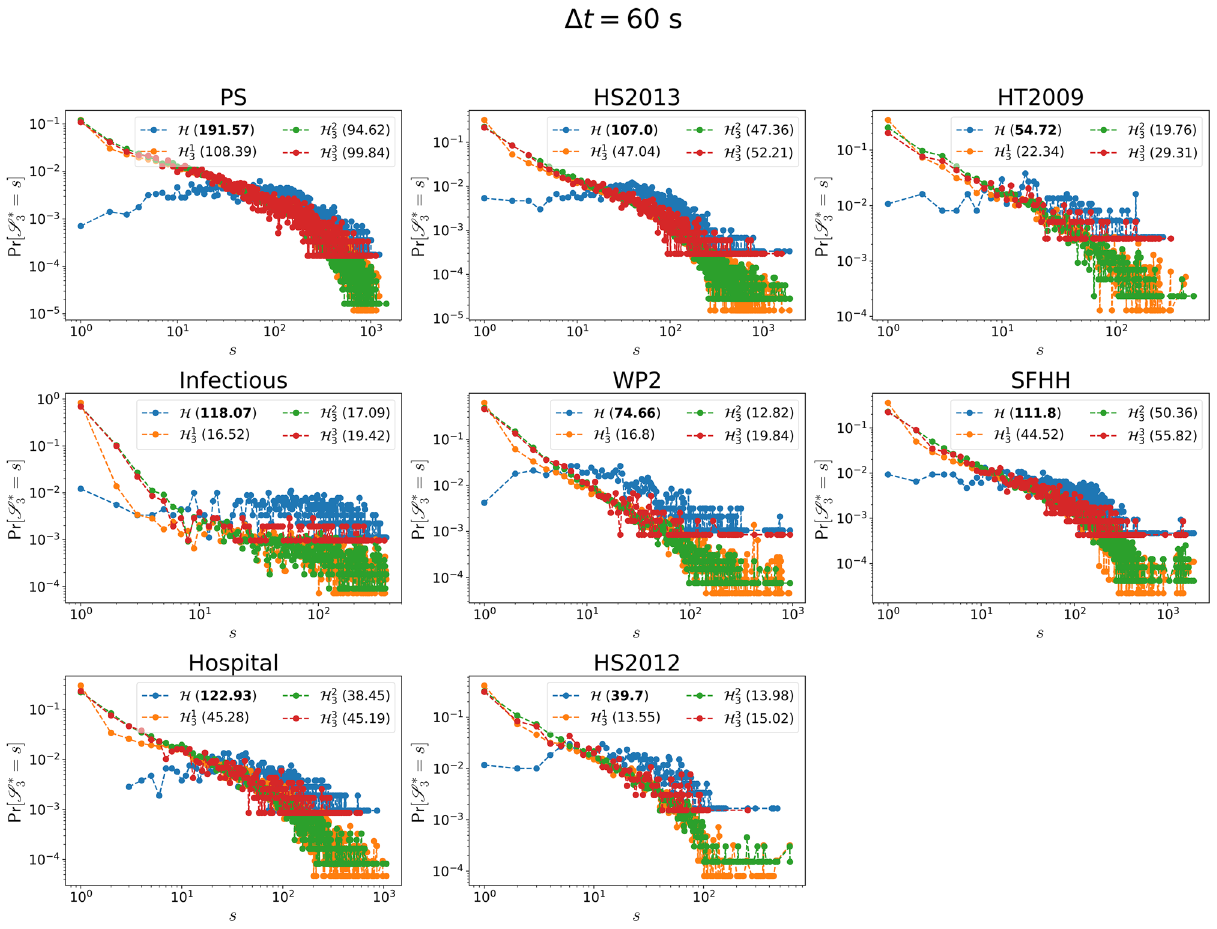
Figure 12. Probability distribution Pr [ S ∗ 3 = s ] of the size S ∗ 3 of trains (obtained from the activity series of egonetworks centered at each order 3 hyperlink), where a center link is activated at least once, in each physical contact network H (blue) and its three randomized reference models H 1 3 (yellow), H 2 3 (green) and H 3 3 (red). To identify the trains, we consider (cid:31) t = 60 s . For each network, the average size of the trains is reported. The maximum average size among network H , H 1 3 , H 2 3 and H 3 3 is in bold. The horizontal and vertical axes are presented in logarithmic